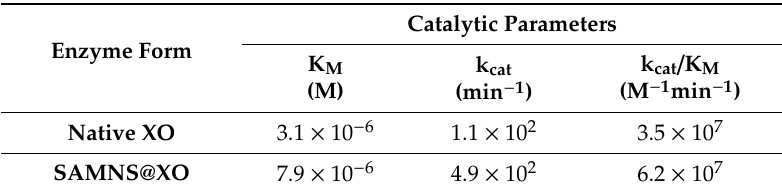
Table 1. parameters of the native XO and SAMN@XO hybrid.